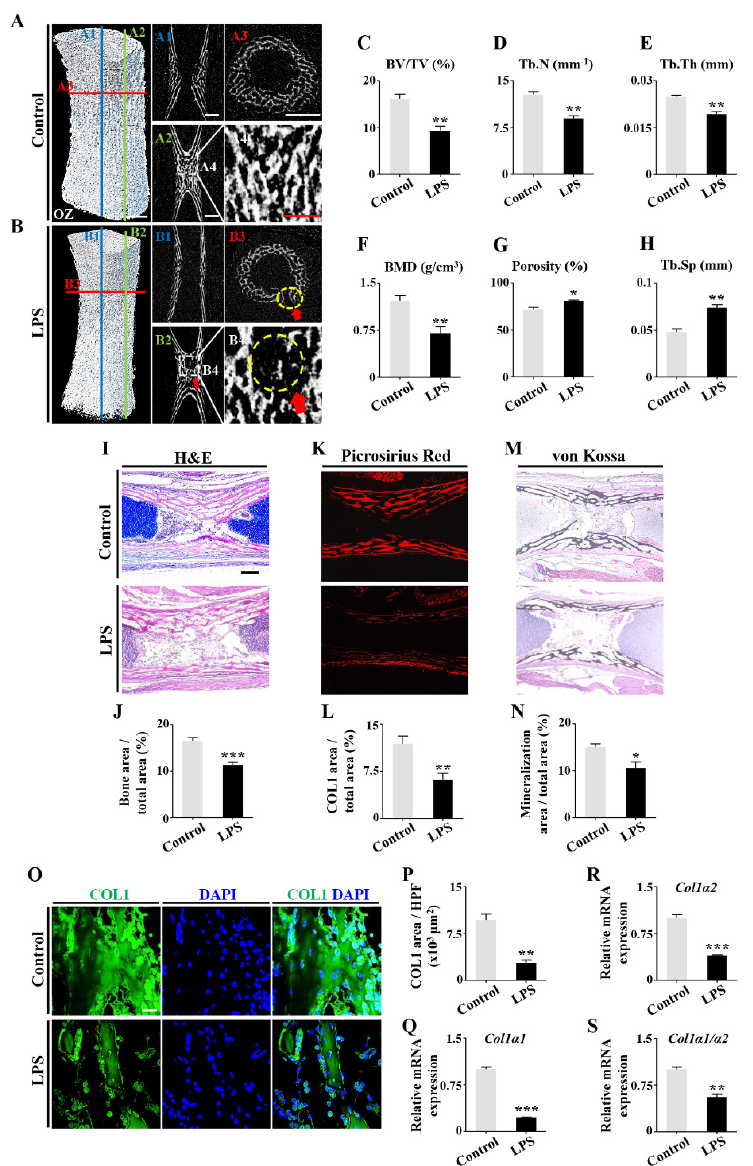
Figure 2. The assessment of osteogenesis in chick embryonic phalanges following LPS treatment. ( A , B ) The representative micro-CT images of the first phalanges of E17 chick embryos of control ( A ) and LPS-treated ( B ) groups. ( A1 – A3 , B1 – B3 ) are the longitudinal or transverse sections as indicated in ( A , B ), while ( A4 , B4 ) are high magnification images of the area indicated in ( A2 , B2 ). Yellow dotted circles in ( B3 , B4 ) show the rupture of and missing trabecular bone in the LPS-treated group. ( C – H ) Bar charts comparing the micro-CT parameters of bone volume fraction (BV / TV), trabecular numbers (Tb.N), trabecular thickness (Tb.Th), bone mineral density (BMD), porosity, and trabecular separation (Tb.Sp) between control and LPS-treated groups. ( I – M ) Representative images of H&E ( I ), Picrosirius red ( K ), and von Kossa ( M ) staining of control and LPS-treated groups. ( J – N ) Bar charts showing the ratios of area of bone ( J ), COL1 ( L ), and mineralization ( N ) of the total area between control and LPS-treated groups. ( O ) Representative immunofluorescent staining of COL1 and DAPI. Negative controls were shown in Supplementary Materials (Figure S6). ( P ) Bar chart showing the area of COL1 per high-powered field (HPF) of control and LPS-treated groups. ( Q , S ) qPCR data showing the mRNA expression of Col1 α 1 ( Q ), Col1 α 2 ( R ), and the ratio of Col1 α 1 / Col1 α 2 ( S ) of control and LPS-treated groups. Scale bars = 0.5 mm in ( A – A3 , B – B3 ); 0.25 mm in ( A4 , B4 , I – M ); 20 µ m in ( O ). OZ: ossification zone. (* p < 0.05, ** p < 0.01, *** p < 0.001)